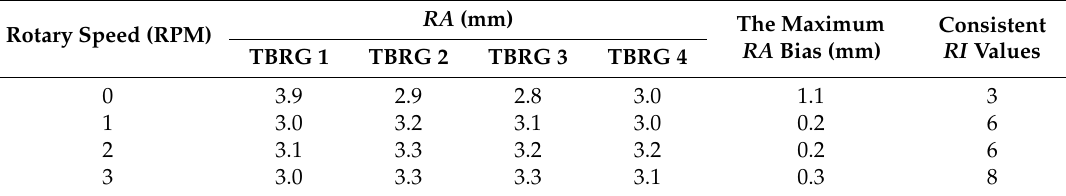
Table 4. The statistical results of RA and RI for the tipping-bucket rain gauge (TBRGs) tests with four selected rotary speeds. The maximum RA bias is the difference between the maximum RA of the four tested TBRGs and the minimum RA at a certain rotary speed. The consistent numbers of RI value are the numbers of the same RI value in every minute among the four TBRGs within 15 min. RA (mm) The Maximum Consistent Rotary Speed (RPM) RA Bias (mm) RI ValuesTBRG